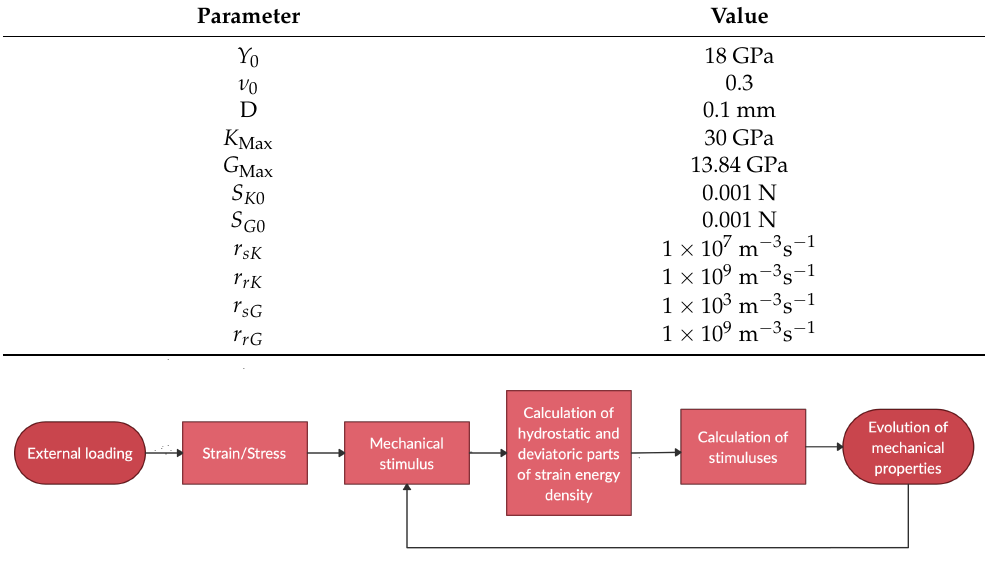
Figure 3. Flow chart of processes.